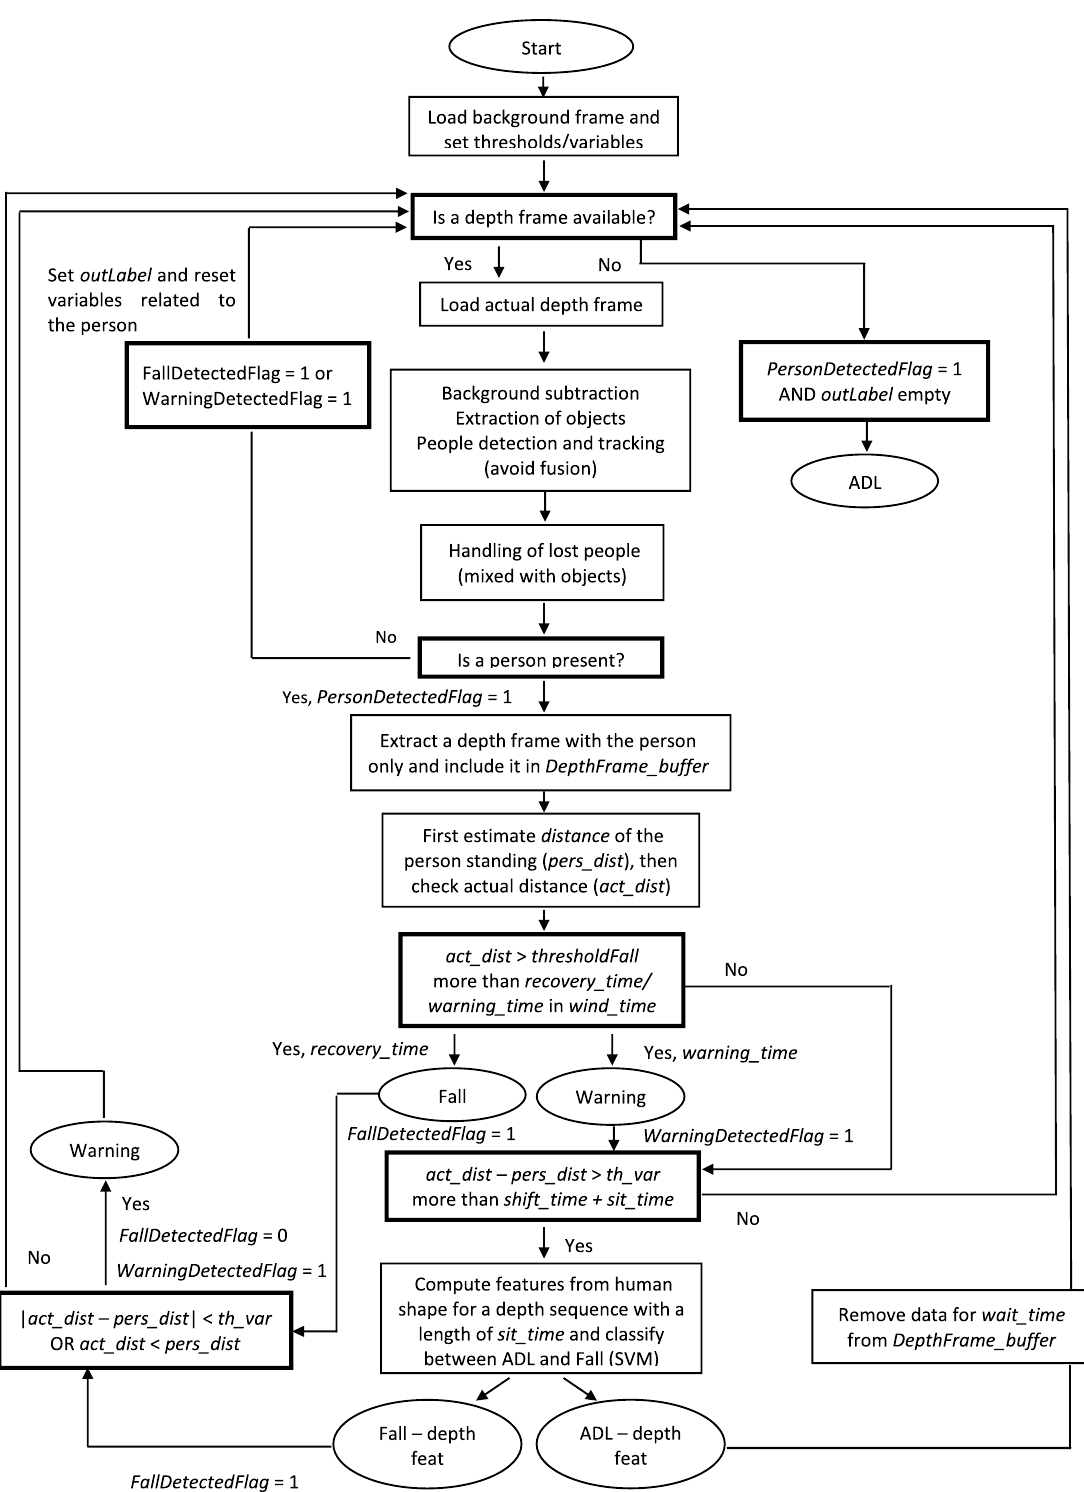
Figure 6. Main scheme of the proposed